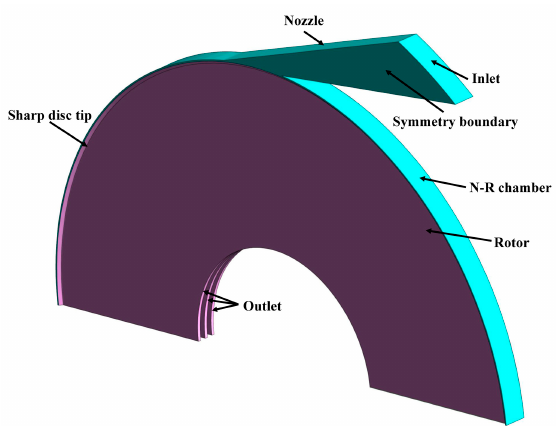
Figure 5 . 3D calculation geometrical region for OTM-T-2 Figure 5. 3D calculation geometrical region for